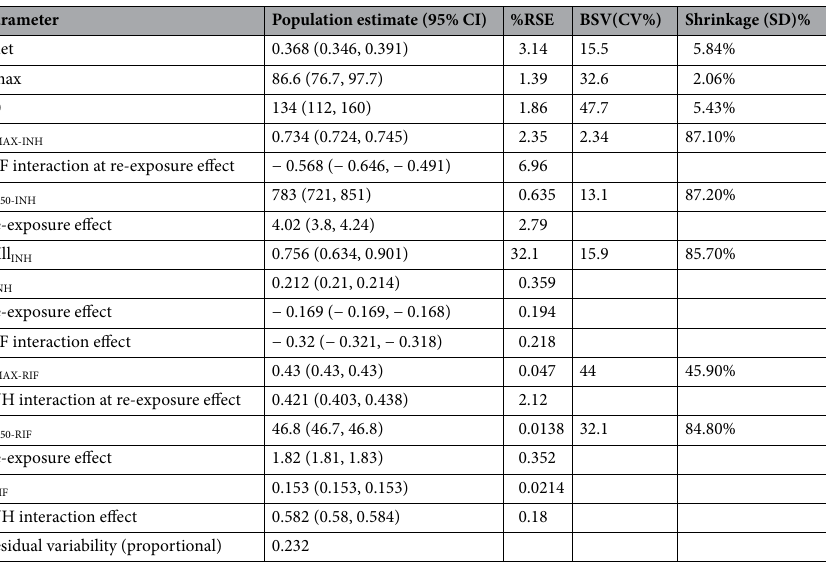
Table 1. Pharmacodynamic parameter estimates. Population, random between experiment variability (BSV), precision (%RSE) and Shrinkage